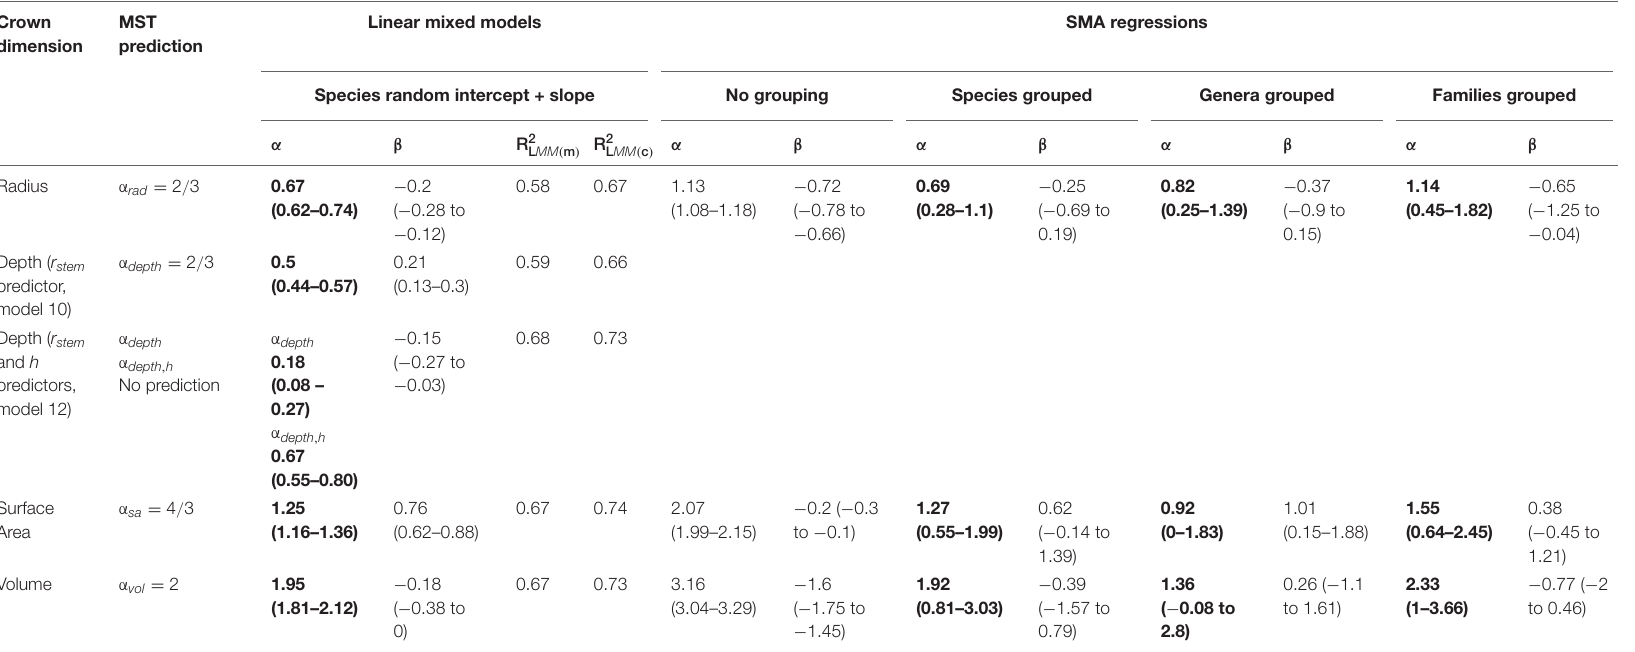
Bold figures are scaling exponents for models with some level of species